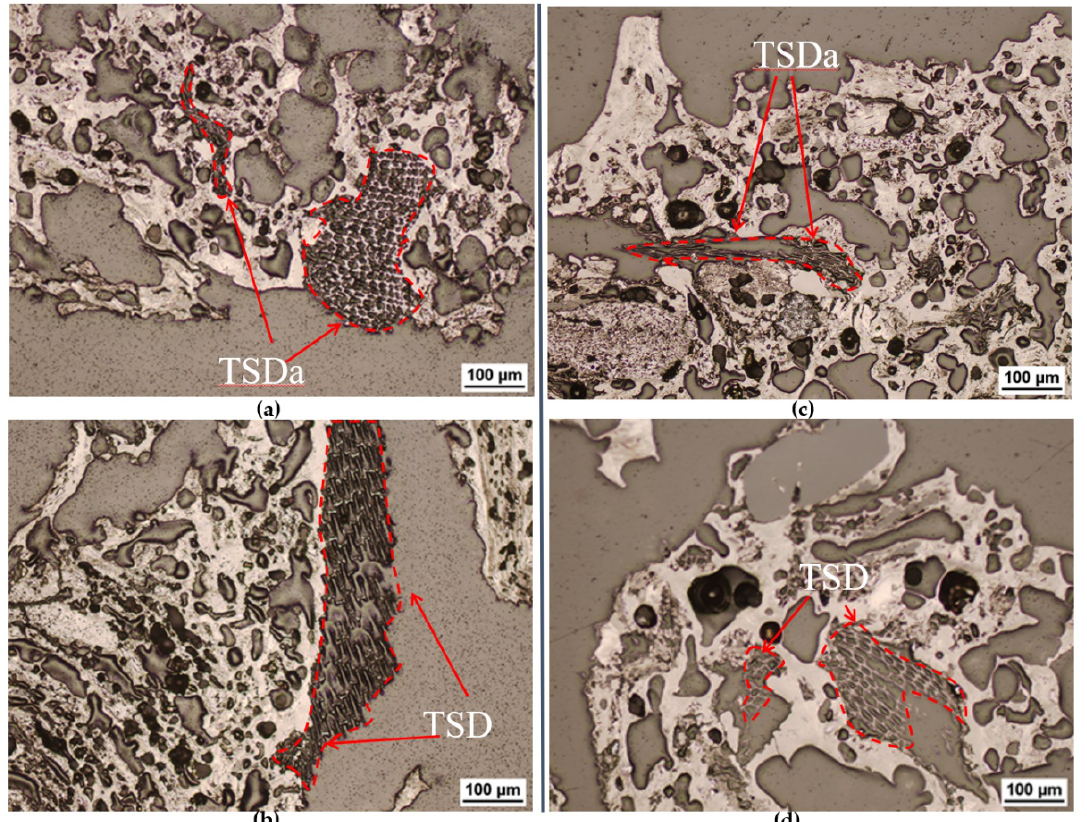
Figure 5. LOM images showing the microstructure for bio-cokes based on BB2 and containing 10% bio-coal, produced bio-cokes are ( a ) BB2_10TSDa and ( b ) BB2_10TSD. Figures ( c ) and ( d ) show bio-cokes collected after interrupted reactivity tests in CO 2 atmosphere up to 1050 °C, ( c ) BB2_10TSDa and ( d ) BB2_10TSD. Red arrows and lines indicate the bio-coal structure in the bio-coke.